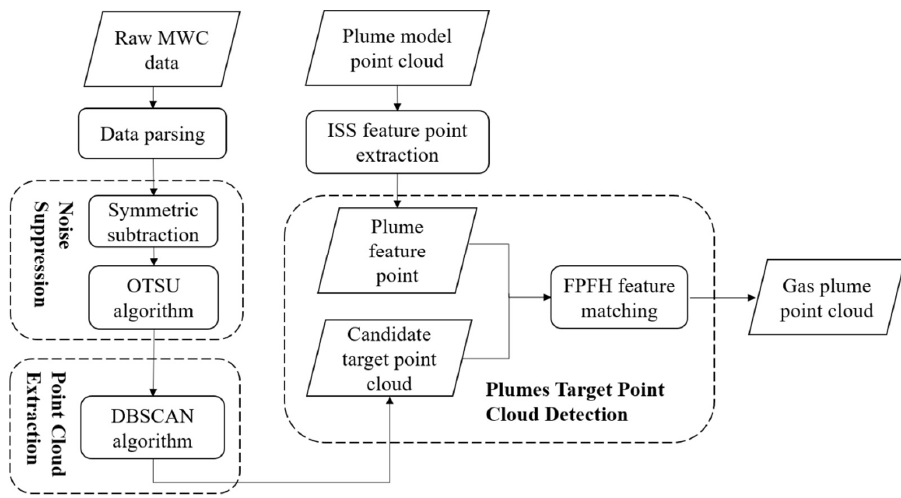
Figure 2. Methodology of this paper.